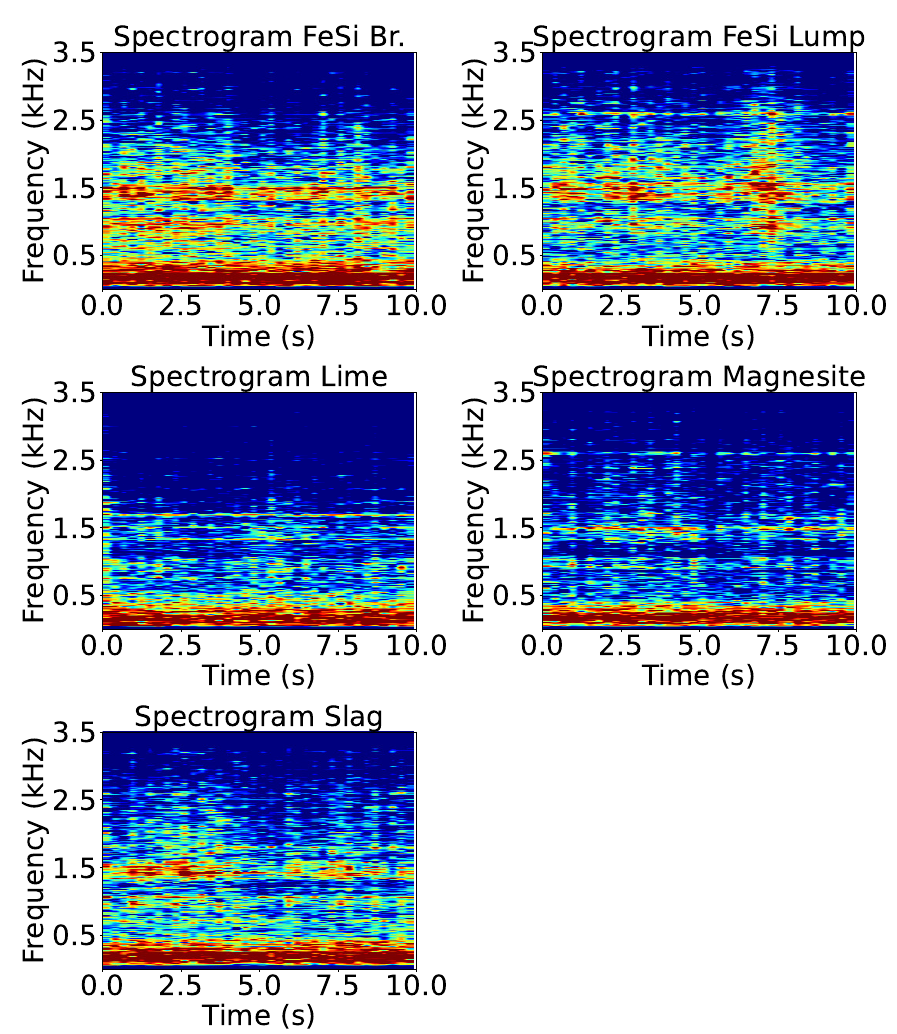
Figure 6. Spectrograms of typical audio signals for different material classes of length 10 s and window width h =